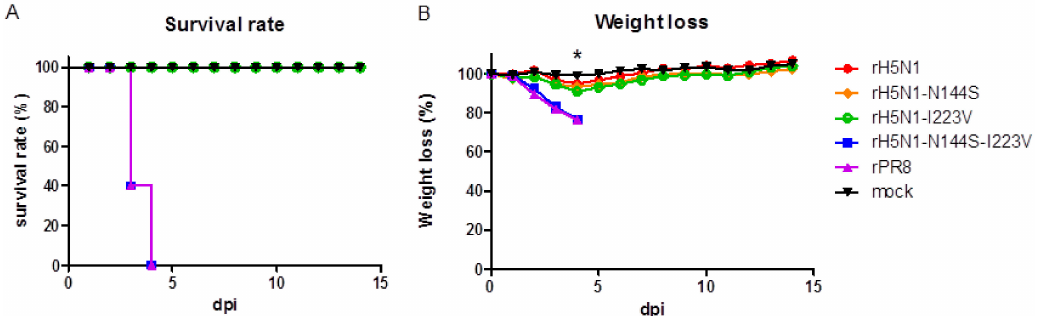
Figure 2. Mouse pathogenicity of recombinant H5N1 viruses. ( a ) Mortality and ( b ) weight loss of mouse experimental groups infected with recombinant H5N1 viruses. Five six-week-old female BALB / c mice per group were inoculated with 10 6 EID 50 of virus or an equivalent volume PBS (mock) intranasally. Weight loss was monitored for 2 weeks, and mice with more than 20% weight loss were euthanized. The weight loss was calculated based on the body weight measured at 0 dpi, and the data are the average of each group; * significant di ff erence of the rH5N1-I223V and rH5N1-N144S groups compared to the mock groups ( p < 0.05). 3.5. Comparison of Binding A ffi nity of the H5N1 Recombinant Viruses to Avian (3 (cid:48) -SLN) and Mammalian (6 (cid:48) -SLN) Receptors and Egg White